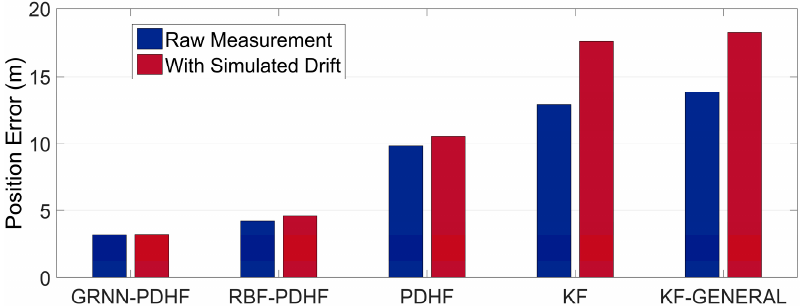
Figure 10. Maximum position error during outage 1 in trajectory 1 while using raw measurement and with extra simulated uncertain nonlinear drift.